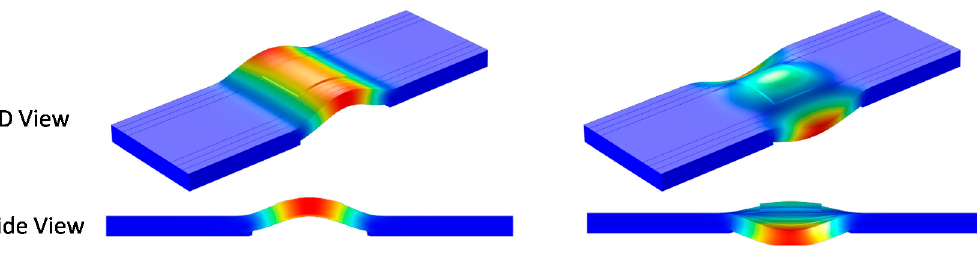
Figure 7. Two bending modes of PZT interface corresponding to Peak 1 and Peak 2.